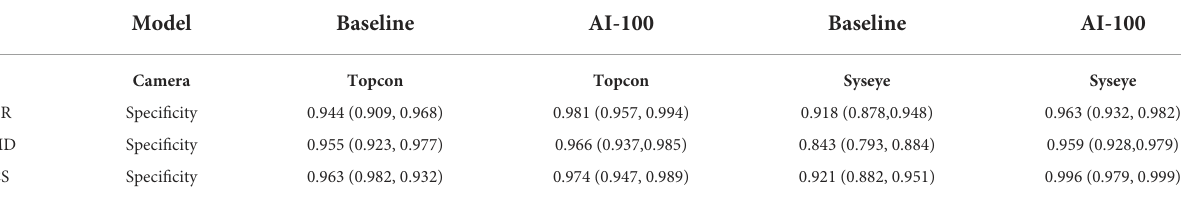
TABLE 7 Specificity values of AI-100 and baseline models on Topcon and Syseye with NSDE data.